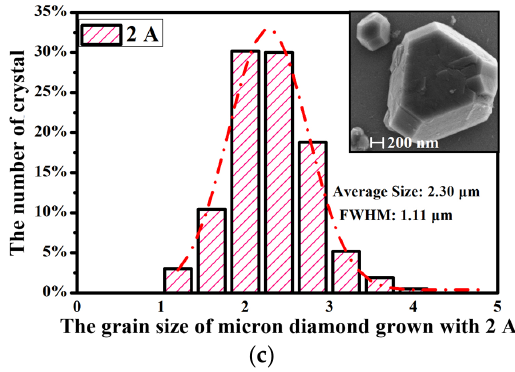
Figure 5. The grain size distribution of CVD microcrystalline diamonds at the bias current of ( a ) 0 A, ( b ) 1 A, and ( c ) 2 A, and their FESEM micrographs under the identical conditions.